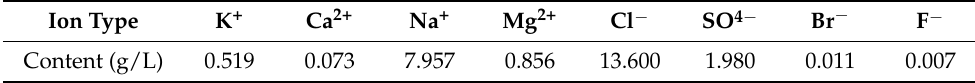
Table 4. Ion content of seawater in Zhairuoshan